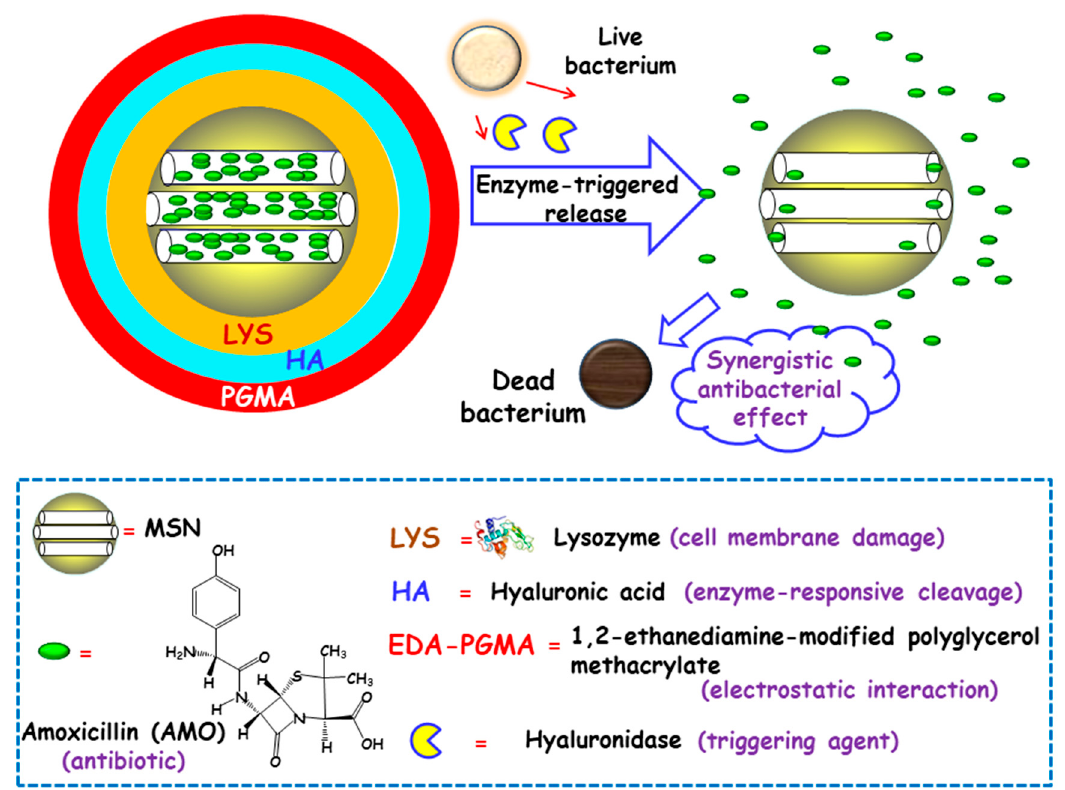
Figure 5. Schematic representation of the operating mechanism of enzyme-responsive antimicrobial nanosystems consisting of layer-by-layer (LBL)coated MSNs loaded with amoxicillin (AMO). Adapted from ref. [ 78] . Lysozyme (LYS) was electrostatically adsorbed onto AMO-loaded carboxylate-modified MSNs and then, sequential coating with hyaluronic acid (HA) and 1,2-ethanediamine-modified polyglycerol methacrylate (EDA-PGMA) was carried out. The presence of hyaluronidase enzyme secreted by bacteria triggers cleavage of the capping layer and allows the release of LYS and AMO, with synergistic antibacterial effect.